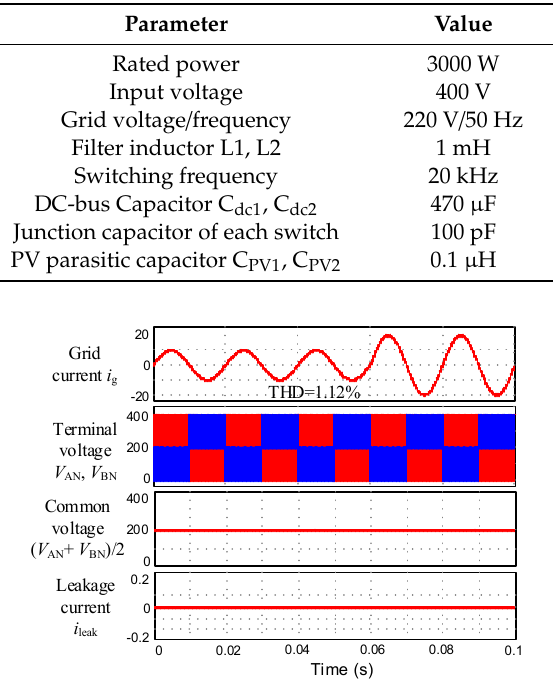
Figure 29. Waveforms of grid current, terminal voltage, CM voltage, and leakage current. Figure 29. Waveform s of grid current, terminal voltage, CM voltage, and leakage current. Table 7. Simulation Parameters.